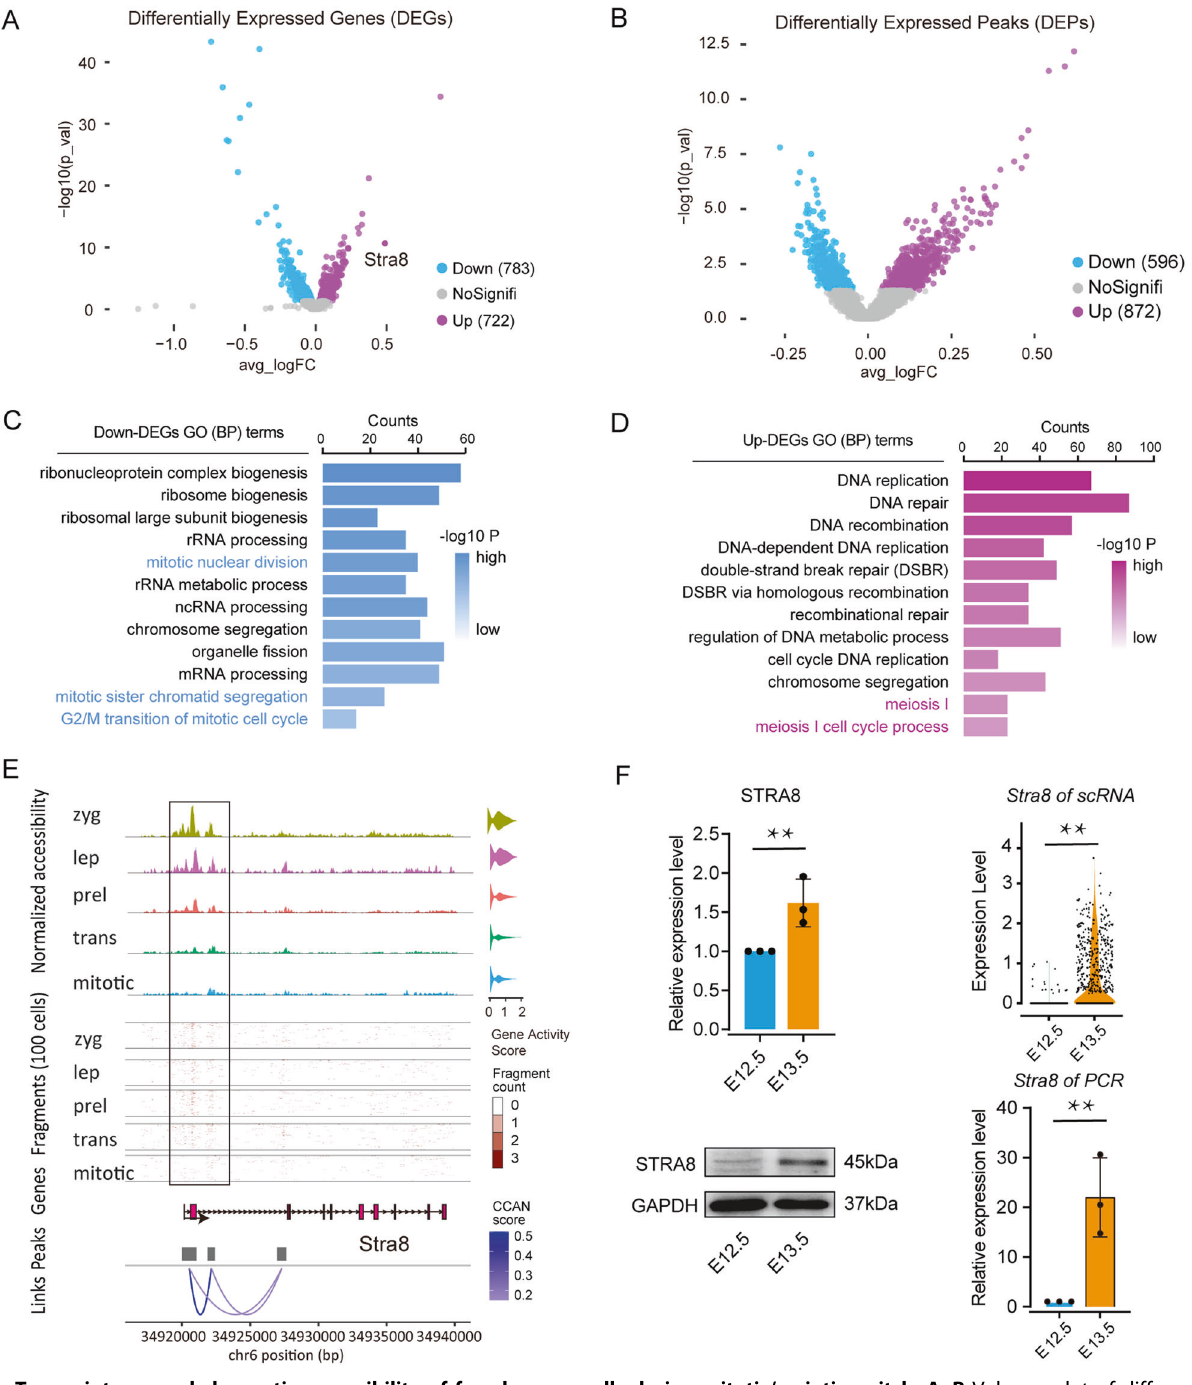
Fig. 4 Transcriptome and chromatin accessibility of female germ cells during mitotic/meiotic switch. A , B Volcano plot of differentially expressed genes (DEGs) and differentially expressed peaks (DEPs): leptotene vs. preleptotene, respectively. Celeste represents downregulation and purple represents upregulation. C , D , GO annotation of down- and up-regulated DEGs, respectively. E Chromatin accessibility of peak related to Stra8 ; Volcano plot shows the gene activity score of Stra8 in cell subtypes; From top to bottom, the epigenetic characteristics of Stra8 , the density of the open region of the middle surface, the structure of the Stra8 gene, the position of the peaks, and the cis-co-accessible networks of stra8 related peaks; mitotic mitotic subtypes, trans transition-phase subtypes, prel preleptotene subtypes, lep leptotene subtypes, zyg zygotene subtype. F Different levels of Stra8 expression between E12.5 and E13.5, including transcript (PCR, n = 3 and scRNA) and protein (WB, n = 3); Compared to E12.5, ** means p value < leptotene to zygotene was signi fi cantly delated. As noted, binding mechanism of TCFL5 function at this stage. RNA interference sites for TCFL5 both on E2f2 and Sycp3 promoters were identi fi ed. experiments showed that siTc fl 5 increased the expression of E2F2 The report that in male testis TCFL5 de fi ciency increased and inhibited the expression of SYCP3 in the cultured ovaries. expression of meiotic genes ( Syce1, Stag3, and Morc2a ) and that Moreover, in line with this latter result, meiotic progression from